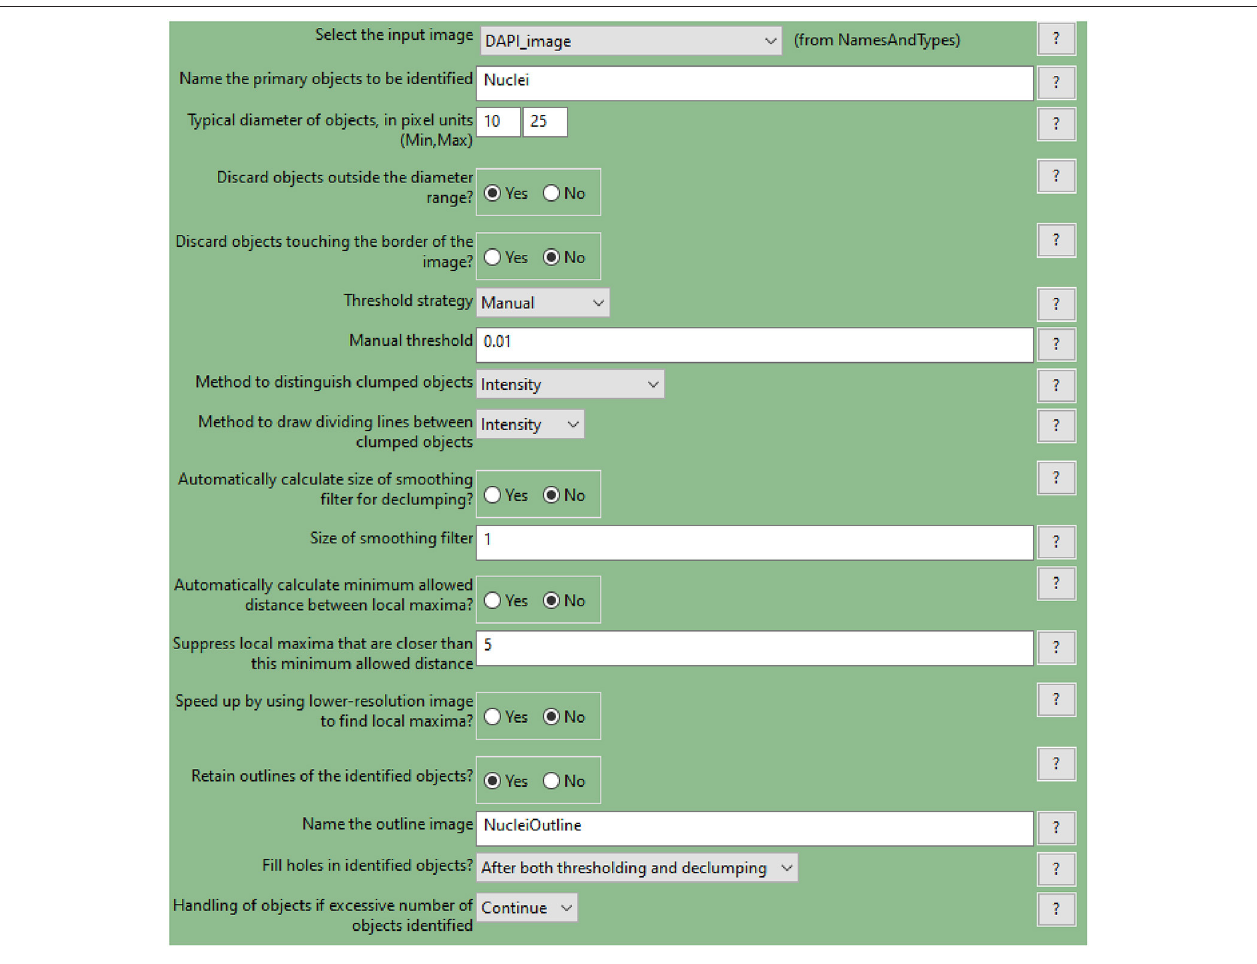
FIGURE 6 | CellProfiler “IdentifyPrimaryObjects” module interface. Parameters used to identify spheroid nuclei for analysis shown in Figure 3 .